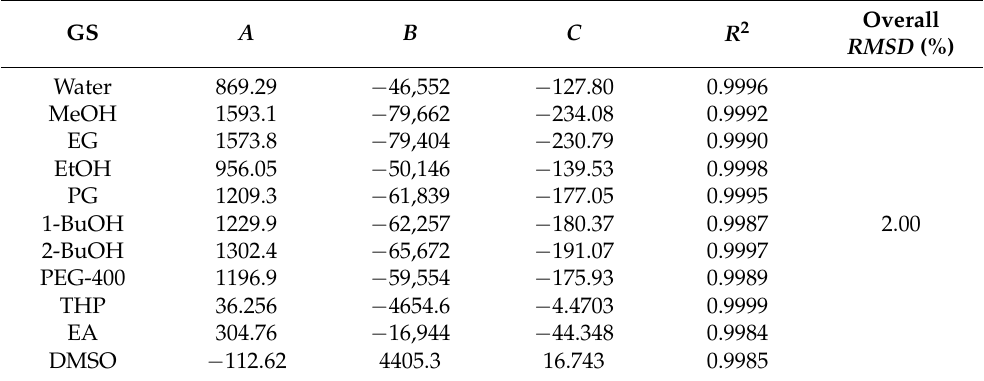
Figure 7. Experimental ITN solubility data in eleven distinct green solvents are correlated with the “Apelblat model” as a function of 1/T. Symbols indicate measured ITN solubility data, whereas solid lines indicate “Apelblat model” ITN solubility data. Table 4. ITN Apelblat model results in terms of model parameters ( A, B and C ), R 2 , and root mean square deviation ( RMSD ) for eleven distinct green